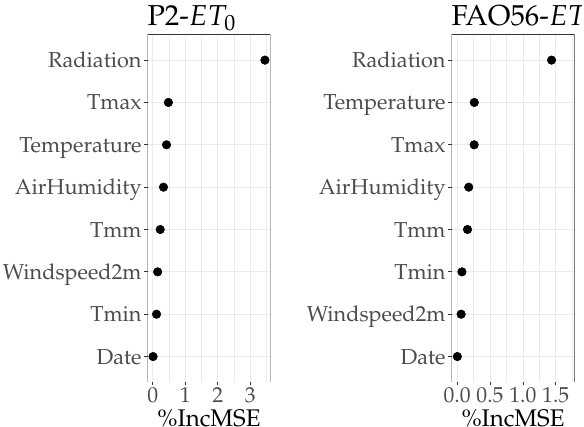
Figure 3. Ranks of variable importance (%IncMSE), for the Random Forest Models P2- ET 0 and FAO56- ET 0 , using weather data of the years 2000–2009 (Explanation of parameters in Table